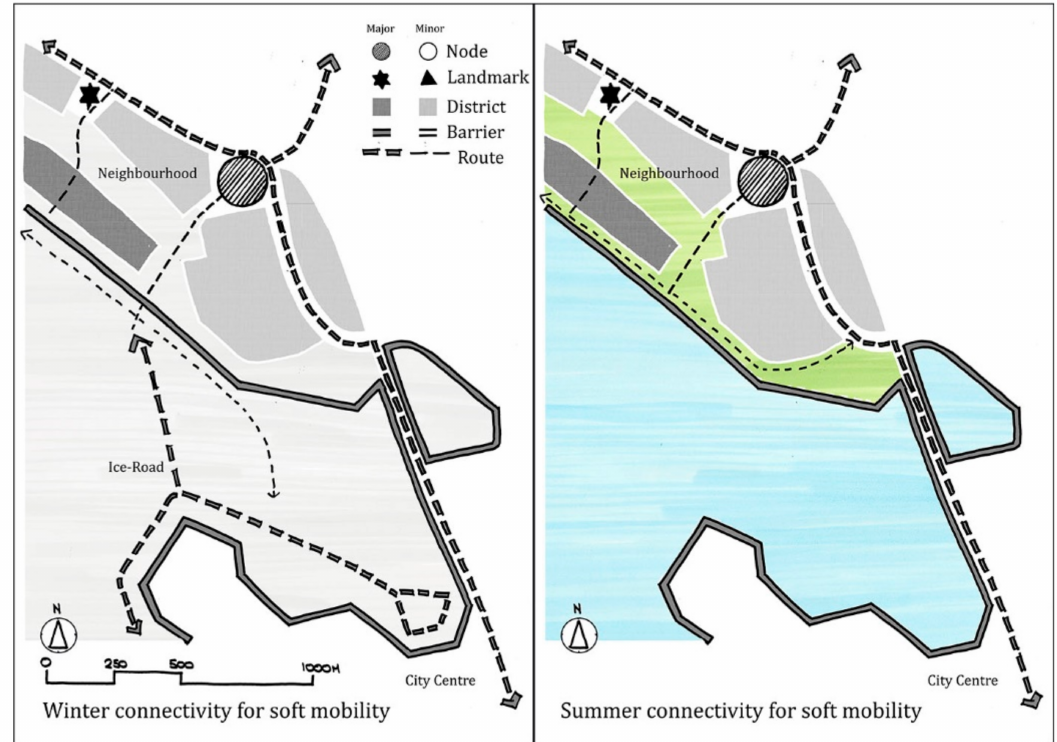
Figure 2. Plan based images compiled from participant mental maps show how the neighbourhood’s connectivity options for soft mobility change in the winter (left) and summer